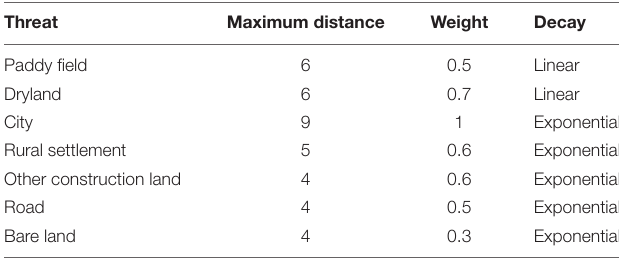
TABLE 2 | Parameter settings for threat